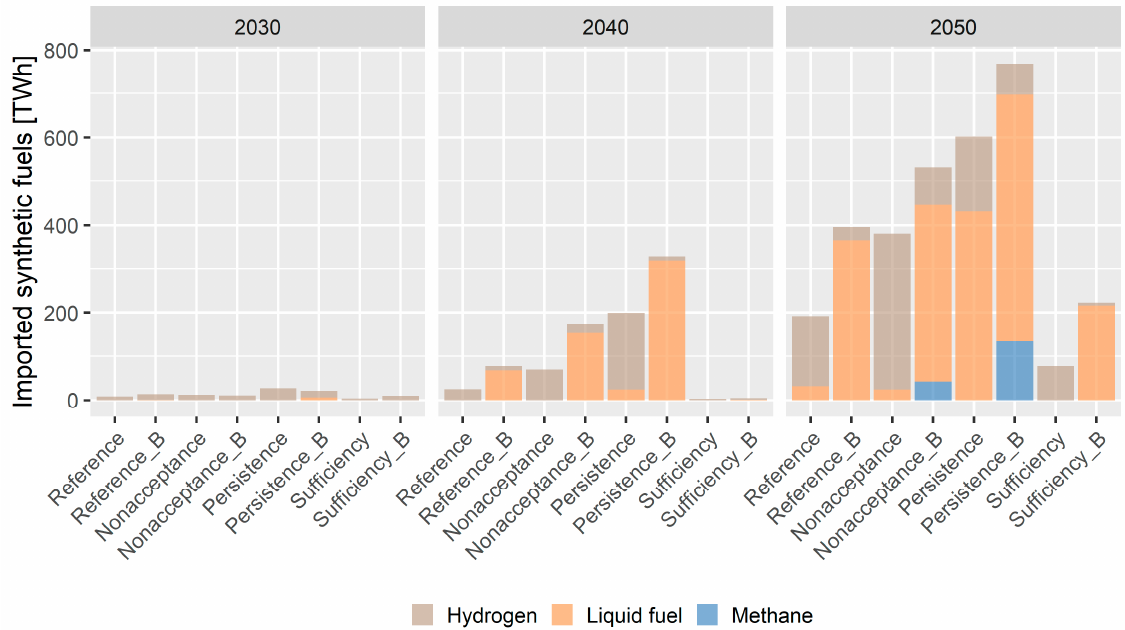
Figure 11. Imported synthetic fuels for the years 2030, 2040, and 2050, in EUR/MWh, for all scenarios of the study and for each the two cases.